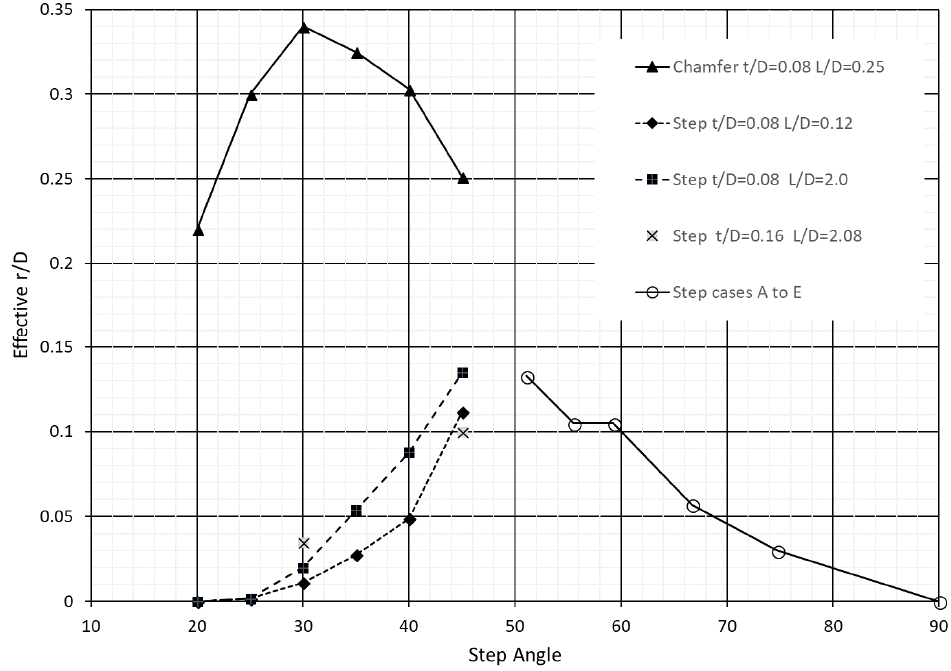
Figure 13. Effective r / D for all stepped inlet cases and chamfered inlet comparison.